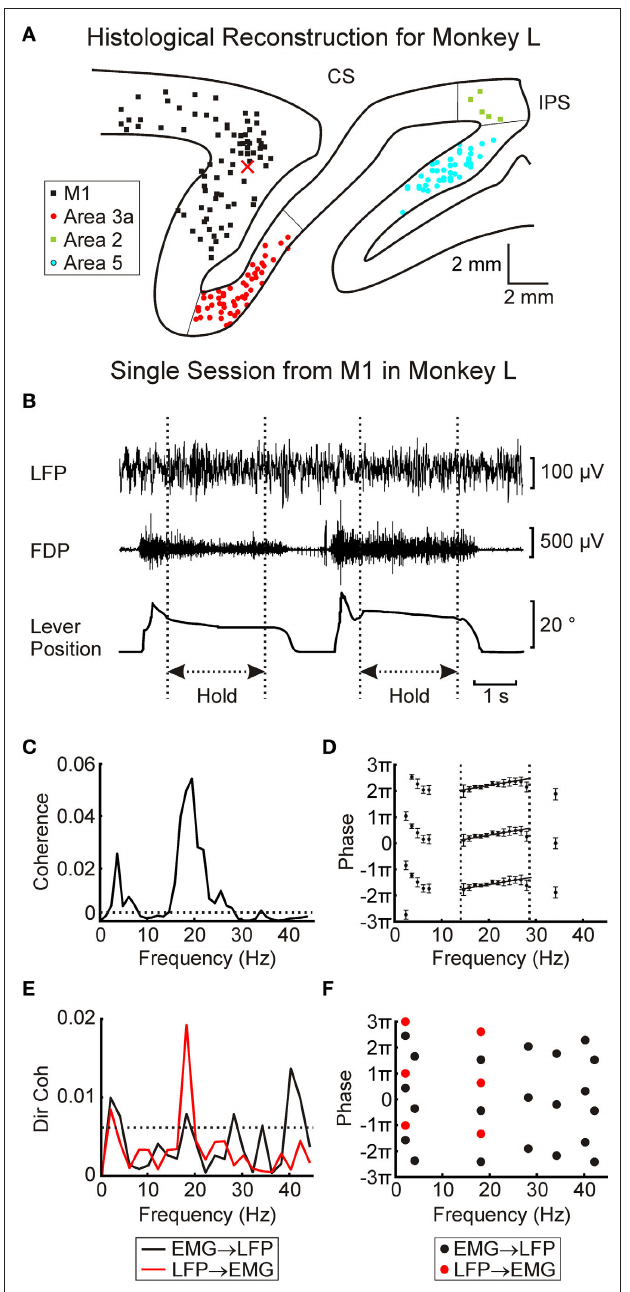
Figure 2 | Data from a single session recording in M1 in monkey L. (A) histological reconstruction of approximate recording sites for monkey L. X marks approximate position of electrode used to record LFP in (B) . (B) raw traces showing LFP, EMG and lever position for two consecutive trials. Dotted lines indicate the hold periods used for analysis. (C) LFP–FDP coherence spectrum. Dotted line indicates P < 0.05 significance level. (D) phase spectrum for LFP–FDP coherence. Error bars show 95% confidence limits. Dotted lines show region used to fit regression analysis, solid lines show best fit. (e) LFP → EMG and EMG → LFP directed coherence spectra. Dotted line represents P < 0.05 significance limit. (F) , phase for frequencies with significant directed coherence. In (D) and (F) , each phase point has been plotted three times separated by 2 π to avoid wrap-around effects when fitting regression lines.